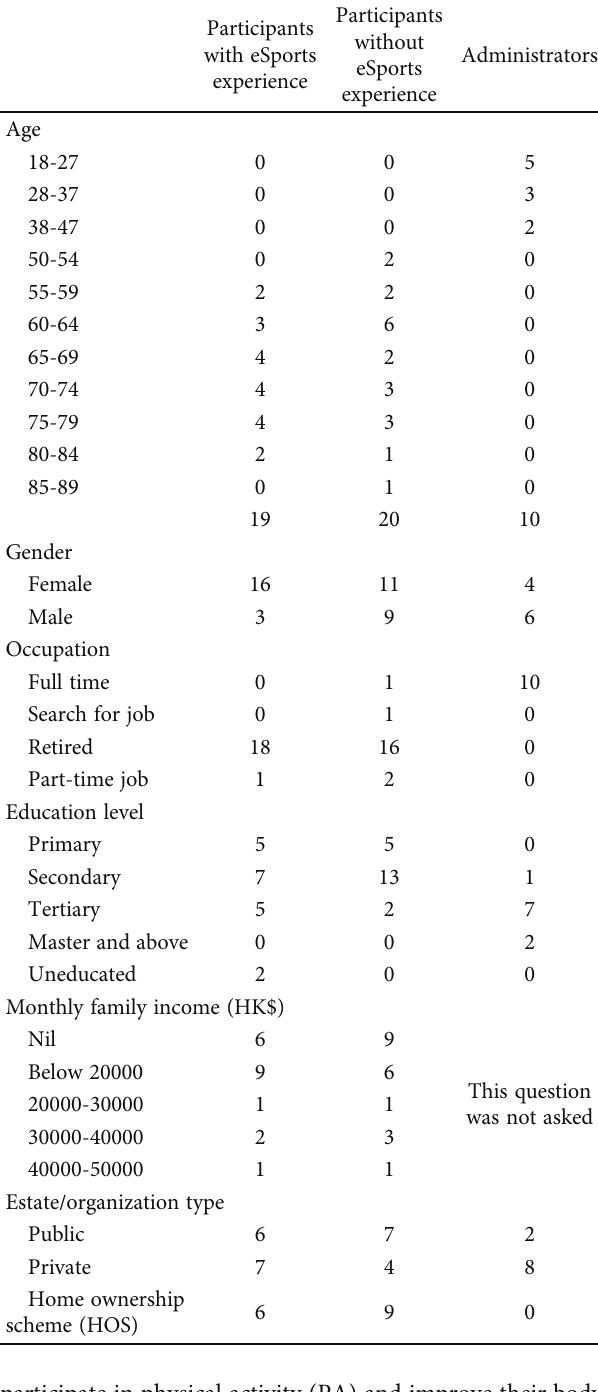
Table 1: Sociodemographic characteristics of participants and